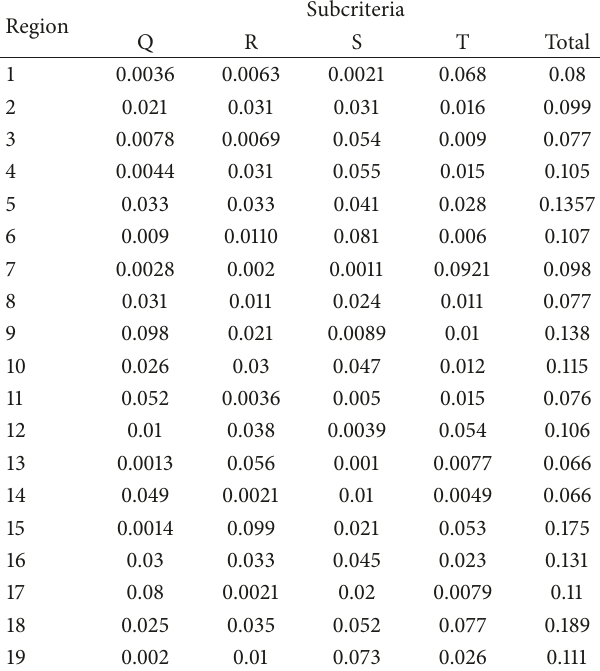
Table 15: Overall priority of each of 19 districts of Qazvin city for the reversibility criteria after the crisis.